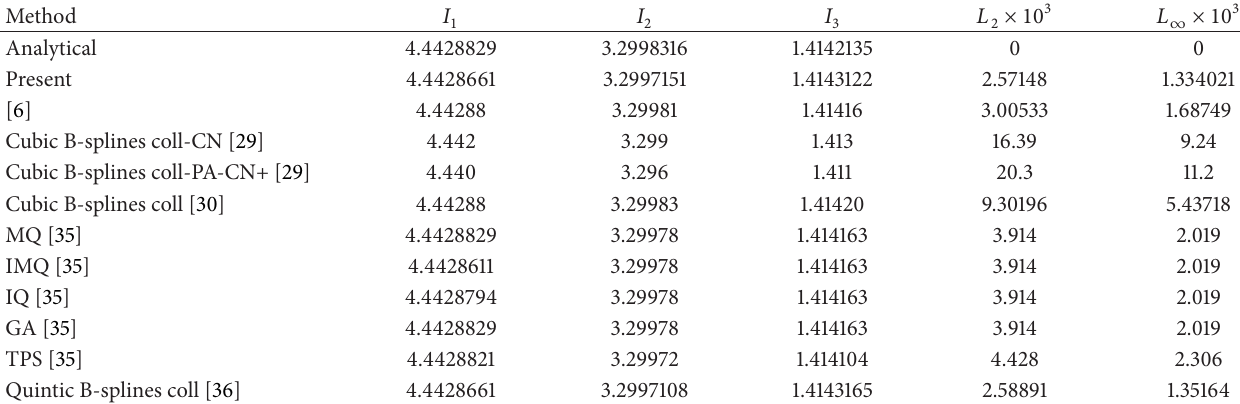
Table 2: Errors and invariants for single solitary wave with 𝑐 = 1 , ℎ = 0.2 , 𝑘 = 0.025 , 0 ≤ 𝑥 ≤ 100 , at 𝑡 = 10 .